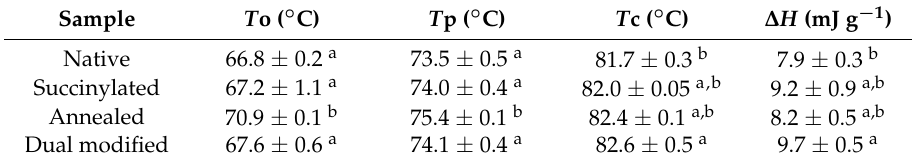
Table 3. Effects of annealing, succinylation, and dual modification on the thermal properties of starch. Sample